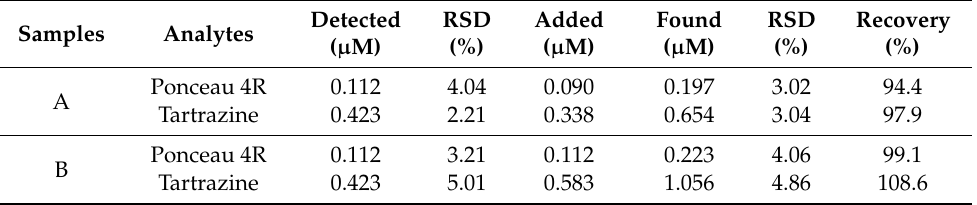
Table 2. Detection of ponceau 4R and tartrazine in soft drink samples by the TiO 2 / ErGO /